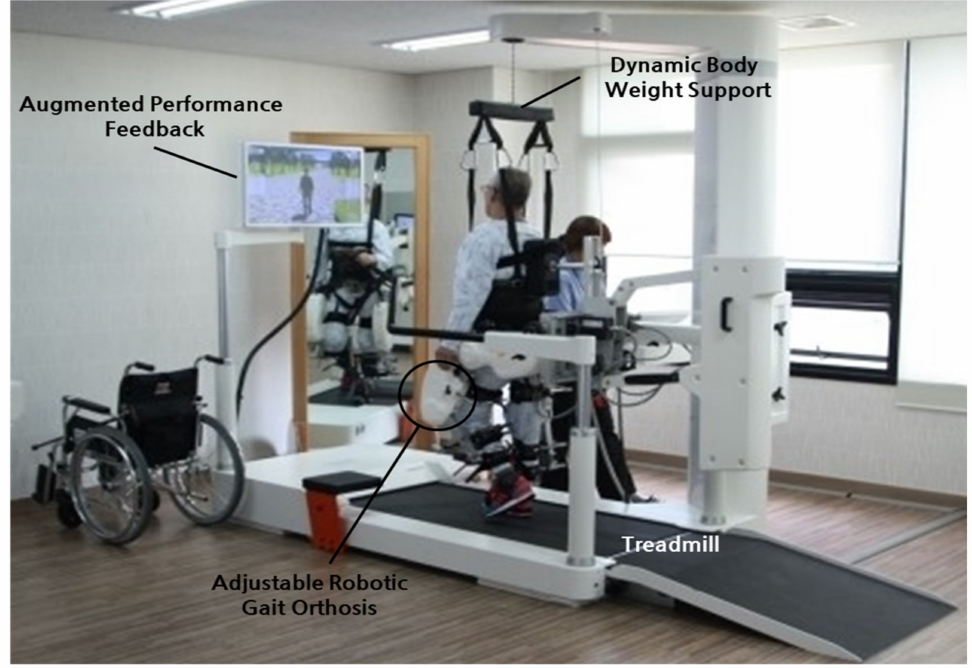
Figure 1. Robot-assisted gait